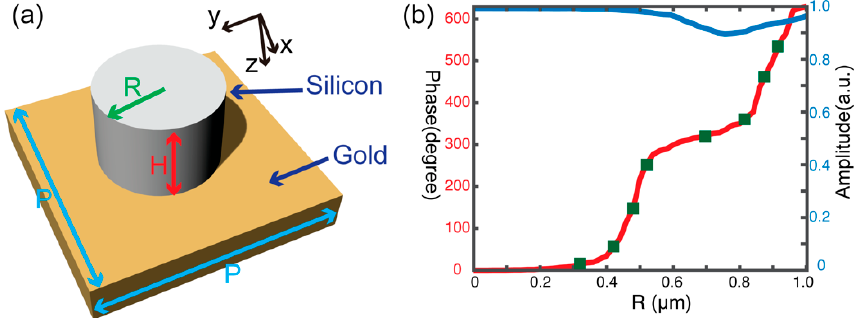
Figure 1. Schematic of the design of the hologram unit. ( a ) Silicon nanopillar with variable radius R and constant period P = 2 μ m and height H = 650 nm is placed on the gold substrate. ( b ) Phase shift (red line) and amplitude (blue line) of the reflection light versus the radii of pillar at wavelength 4.7 μ m.